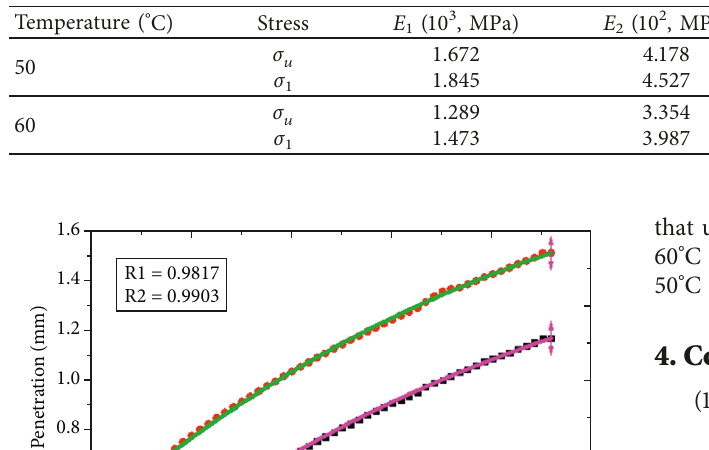
Table 3: Summary of model parameters.